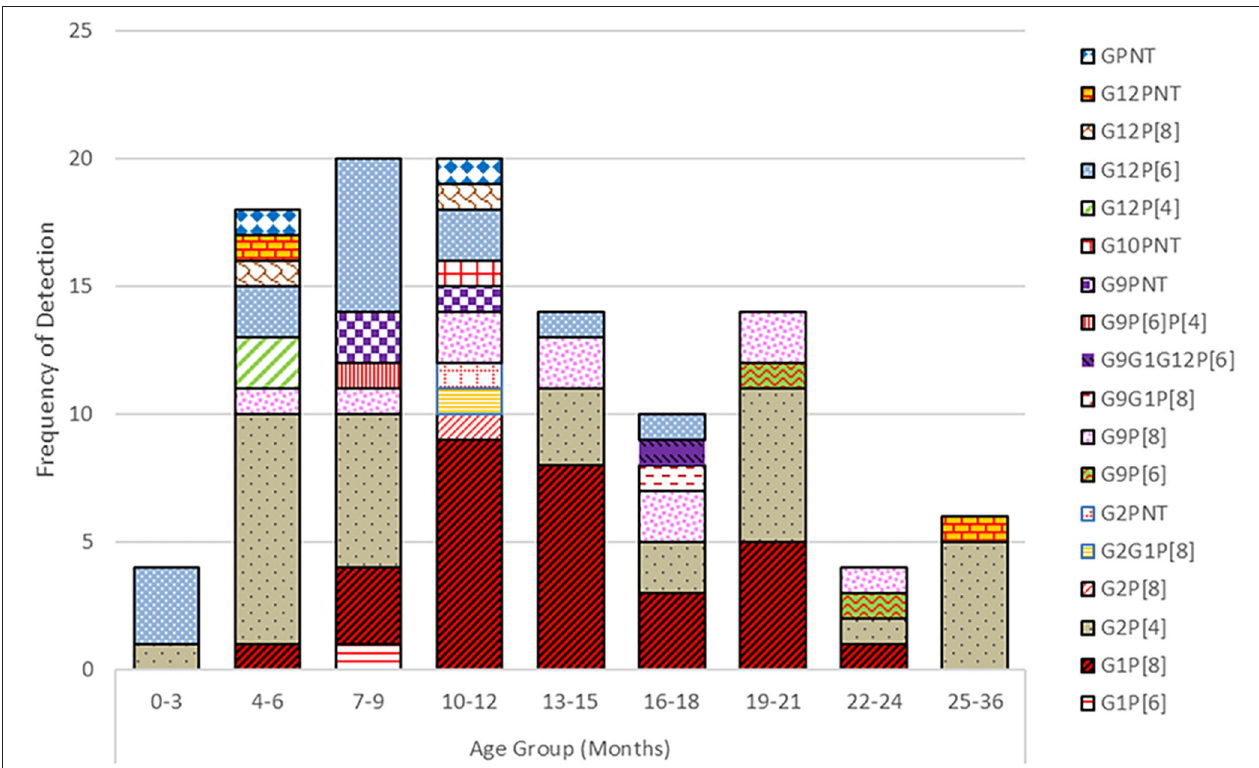
FIGURE 3 | Prevalence of G and P genotypes combination of the rotavirus strains detected in different age groups of children.